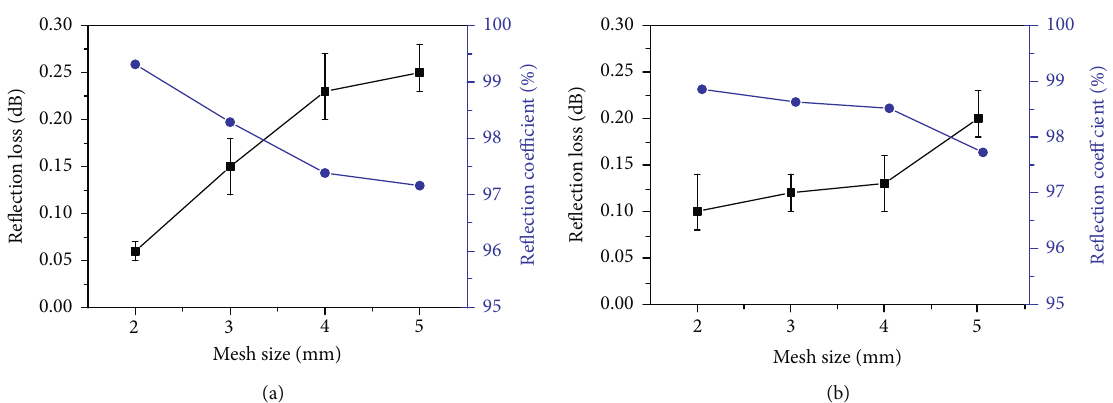
Figure 7: E ff ect of mesh size on the electrical property of the continuous fi ber reinforced thermoplastic composites re fl ecting surfaces: (a) quadrangular mesh re fl ecting surface; (b) triangular mesh re fl ecting surface.